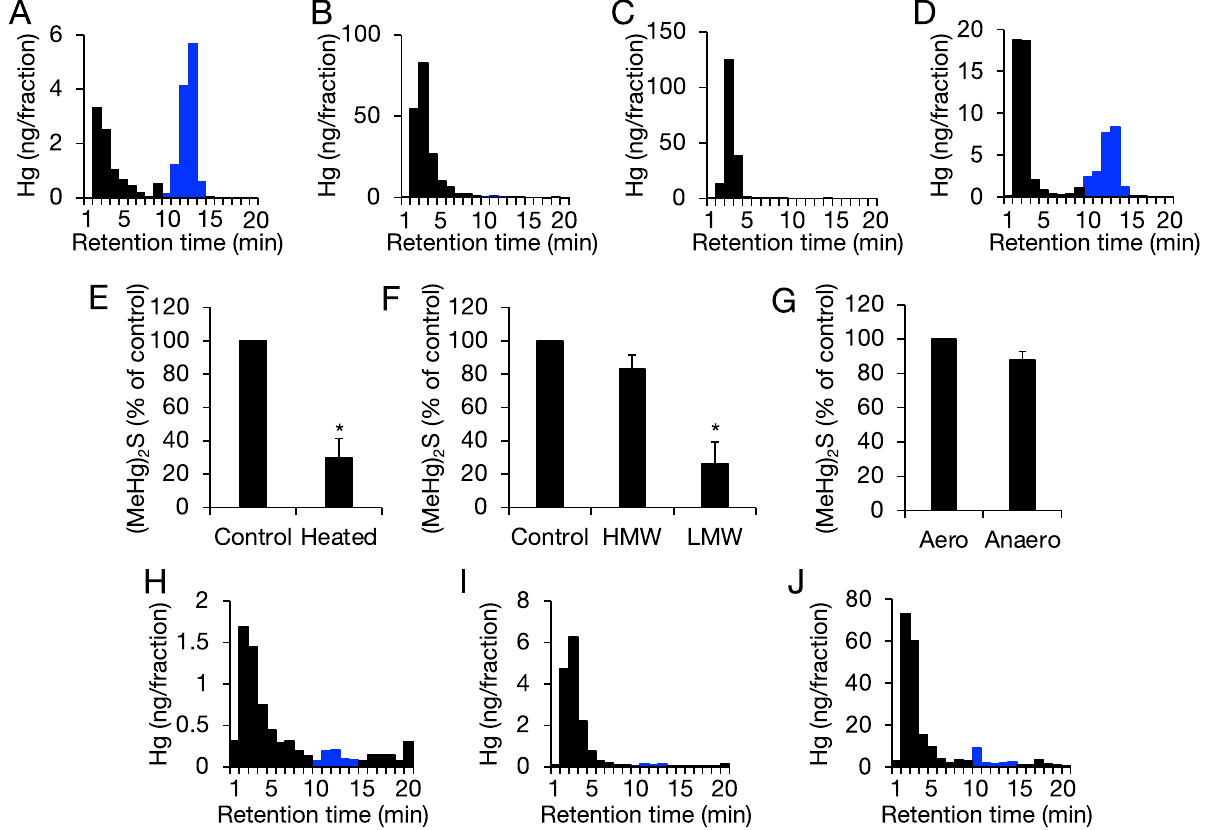
Figure 2. Detection of bismethylmercury sulfide as a reaction product of methylmercury with intestinal content in vitro and in vivo . Blue bars indicate (MeHg) 2 S. MeHg (200 µM) was incubated in mouse ( A ) distal colon or ( B ) duodenum with content, ( C ) distal colon without content, or ( D ) 10 mg of the content for 30 min. ( E ) MeHg (200 µM) was incubated with 10 mg of the content, which was preincubated at 25 °C (control) or 95 °C (heated) for 15 min, for 30 min. Each value of (MeHg) 2 S is the mean ± SE of three determinations. * P < 0.05 vs. control. ( F ) MeHg (200 µM) was incubated with 50 mg/mL homogenized content (control), its high-molecular-weight fraction (HMW), or its low-molecular-weight fraction (LMW) for 30 min. The control sample was incubated in a tube under atmospheric air. Each value of (MeHg) 2 S is the mean ± SE of three determinations. * P < 0.05 vs. control. ( G ) MeHg (200 µM) was incubated with homogenized intestine contents (50 mg/mL) for 30 min under anaerobic conditions (anaero). The control sample was incubated under atmospheric air (aero). Each value of (MeHg) 2 S is the mean ± SE of three determinations. After 18 h of a single treatment with MeHg (10 mg/kg, p.o.), ( H ) the distal colon and ( I ) duodenum contents were collected. ( J ) The feces from mice given MeHg (10 mg/kg, p.o.) was collected after 18 h–42 h of exposure. The samples were analyzed by HPLC/AAS. Representative data are